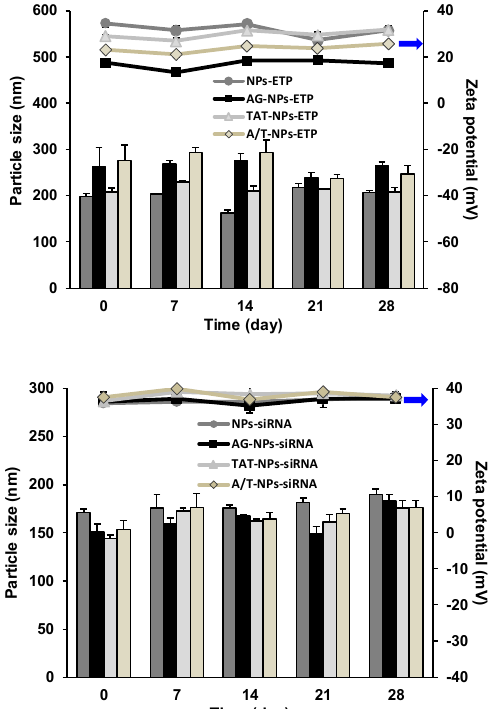
Figure 2. Stability of lyophilized ( A ) ETP@NPs and ( B ) siRNA@NPs at − 20 ° C for 28 days by monitoring the particle size (bar) and zeta potential (line) change during storage. ( n = 3, mean ± SD).